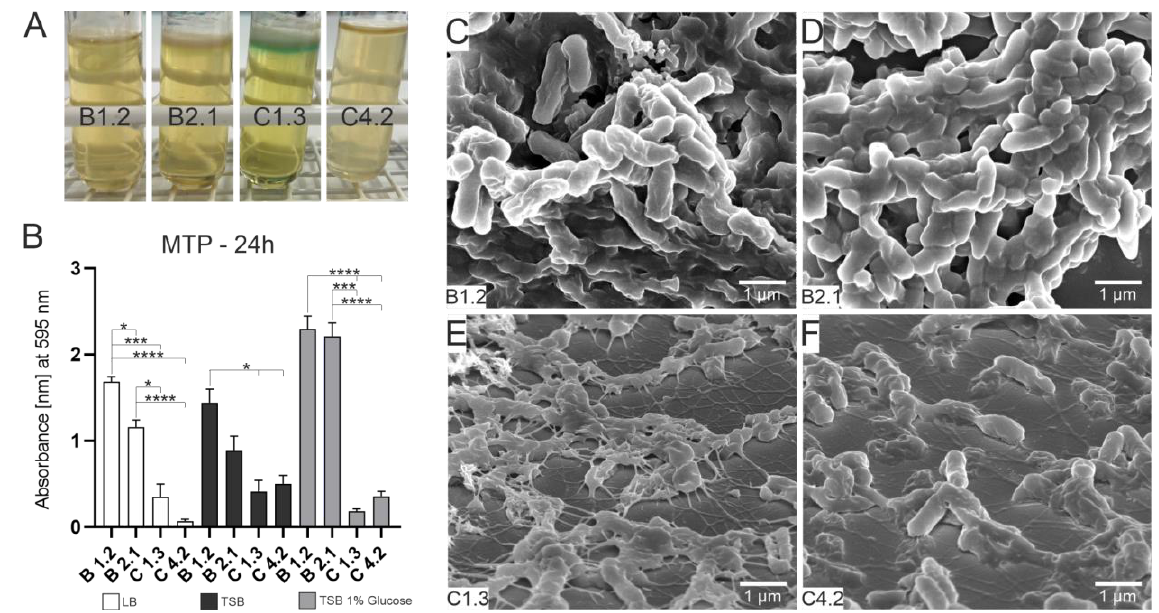
Figure 1. Phenotyping of the four P. aeruginosa WM isolates. Static growth behavior was investigated in LB medium for 72 h ( A ). Only C1.3 was able to produce a yellow-greenish color at the water–air interface. Microtiter plate assay using crystal violet staining was performed for a quantification of the biofilm-forming potential of the four isolates ( B ). The two B isolates had significantly higher absorbance values, indicating them to be the strongest biofilm producers. Means ± standard error of the mean (SEM) were statistically analyzed by Brown – Forsythe and Welch ANOVA tests ( p < 0.05 (*), p < 0.001 (***), p < 0.0001 (****)). Data passed the D’Agostino and Pearson normality test (alpha = 0.05). Ultrastructural analysis of biofilm formation was performed by SEM (C-F). SEM images reveal that both B isolates show vertical growth and even biofilm-typical structures such as supply channels and matrix production ( C , D ). For the C isolates, initial biofilm stages can be observed ( E , F ), such as network structures and initial matrix production, but no multilayered growth appeared.